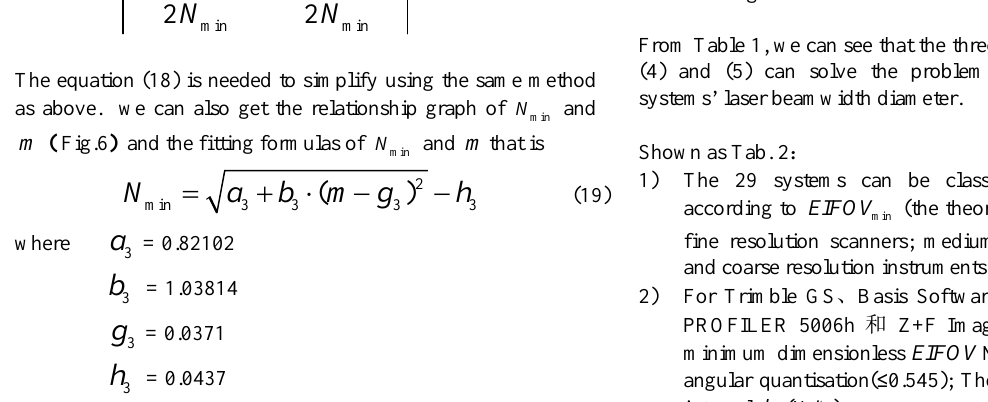
2) For Trimble GS 、 Basis Software Surphaser 25HS 、 Z+F PROFILER 5006h 和 Z+F Imager 5003: The theoretical minimum dimensionless EIFOV N(>1); The dimensionless angular quantisation( ≤ 0.545); The dimensionless scanning interval k 2